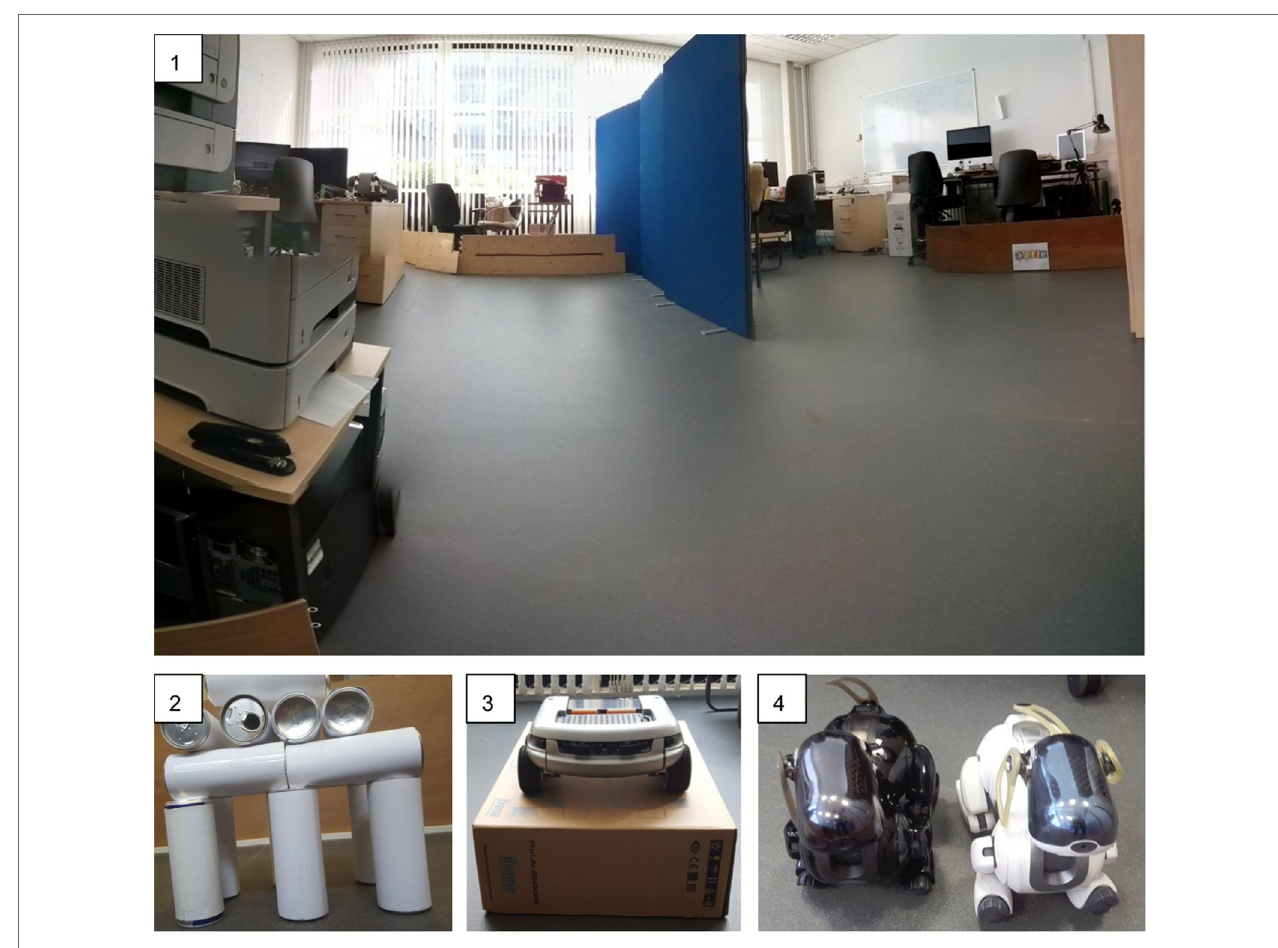
FigUre 5 | Different aspects of the environment used during the experiments . (1) shows a panoramic picture of the standard open environment used during 3.1 and 3.2. (2) shows an example of one of the novel structures used during experiment 3.2. (3) shows the koala robot used during this work and the cardboard box the robot was placed in to create a sensory deprivation environment. (4) shows two AIBO robots used as novel objects in the test described in Section